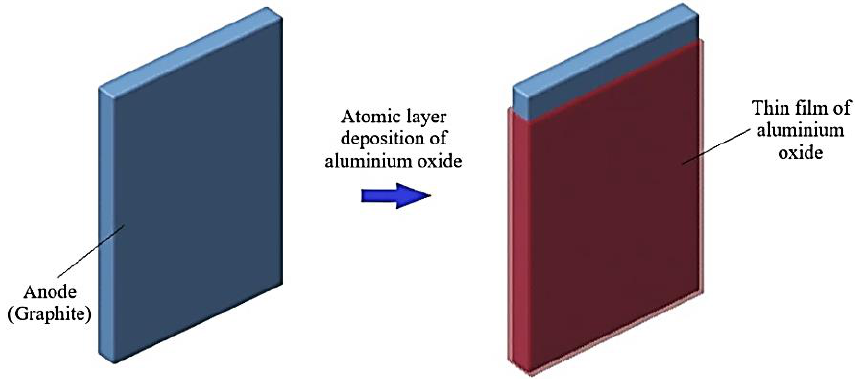
Figure 14. Atomic layer deposition process in the anode.